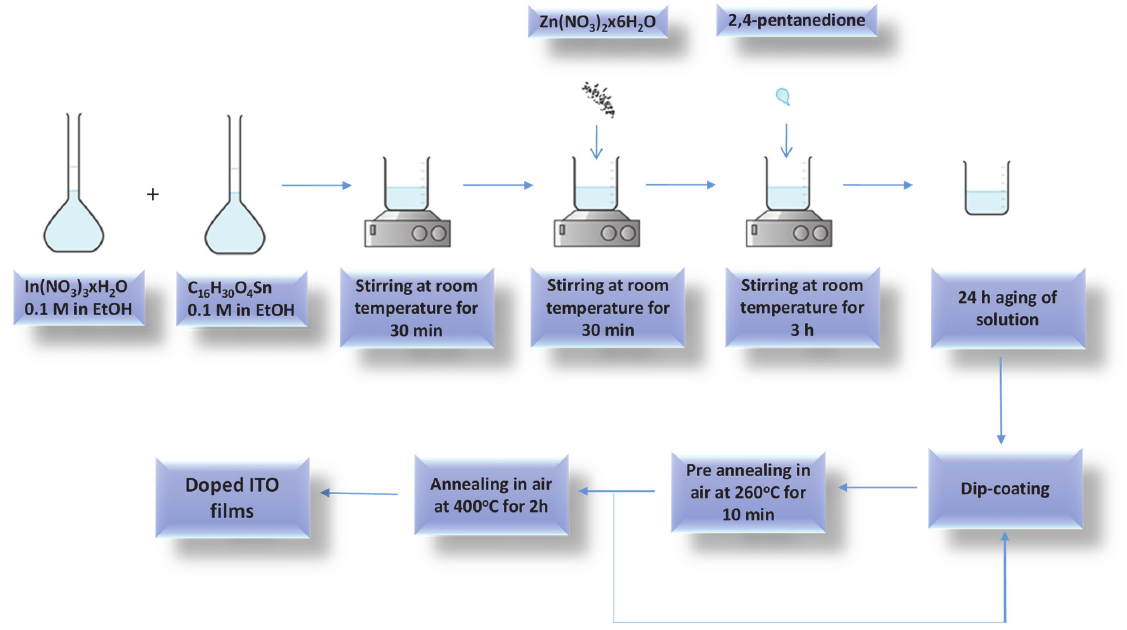
Figure 1. Flowchart for the preparation of the ITO:Zn thin films.